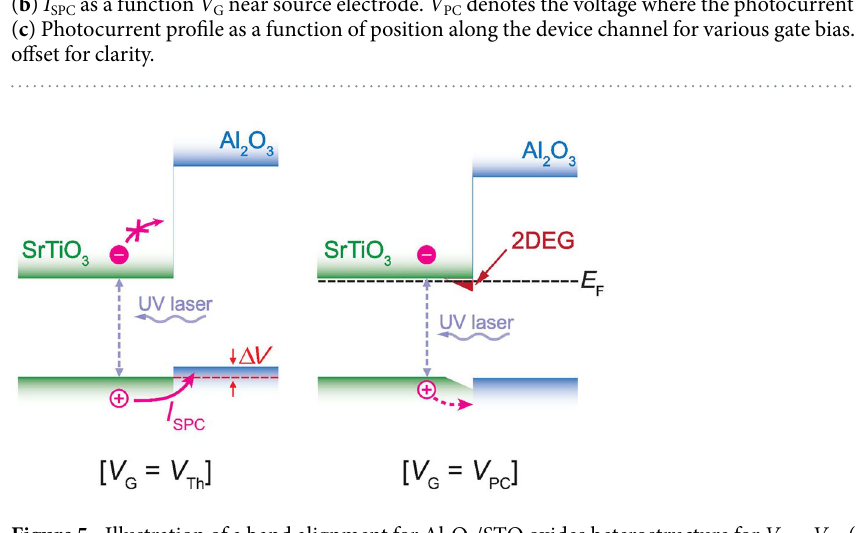
Figure 5. Illustration of a band alignment for Al 2 O 3 /STO oxides heterostructure for V G = V Th (left) and V G = V PC